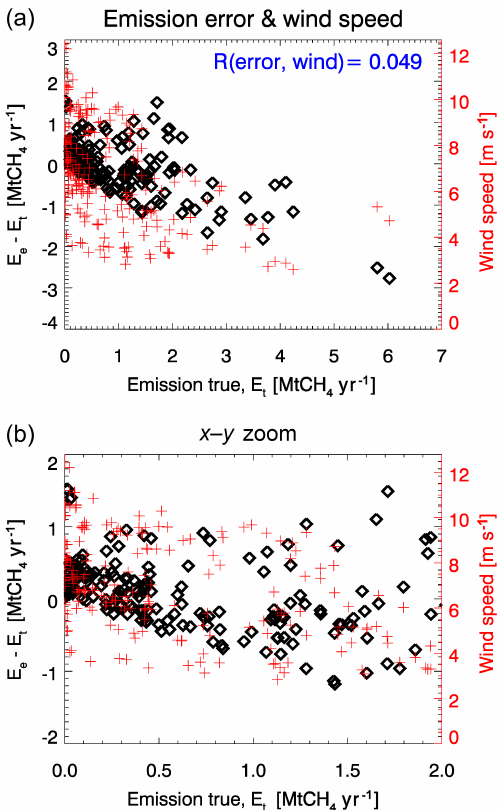
Figure 7. Error of the estimated emission (black symbols; com- puted as “retrieved–true”; see Fig. 6) versus annual mean wind speed (red crosses) at 900hPa. (a) All data; (b) same data but x – y zoom. The linear correlation coefficient between annual emis- sion error and annual mean wind speed is